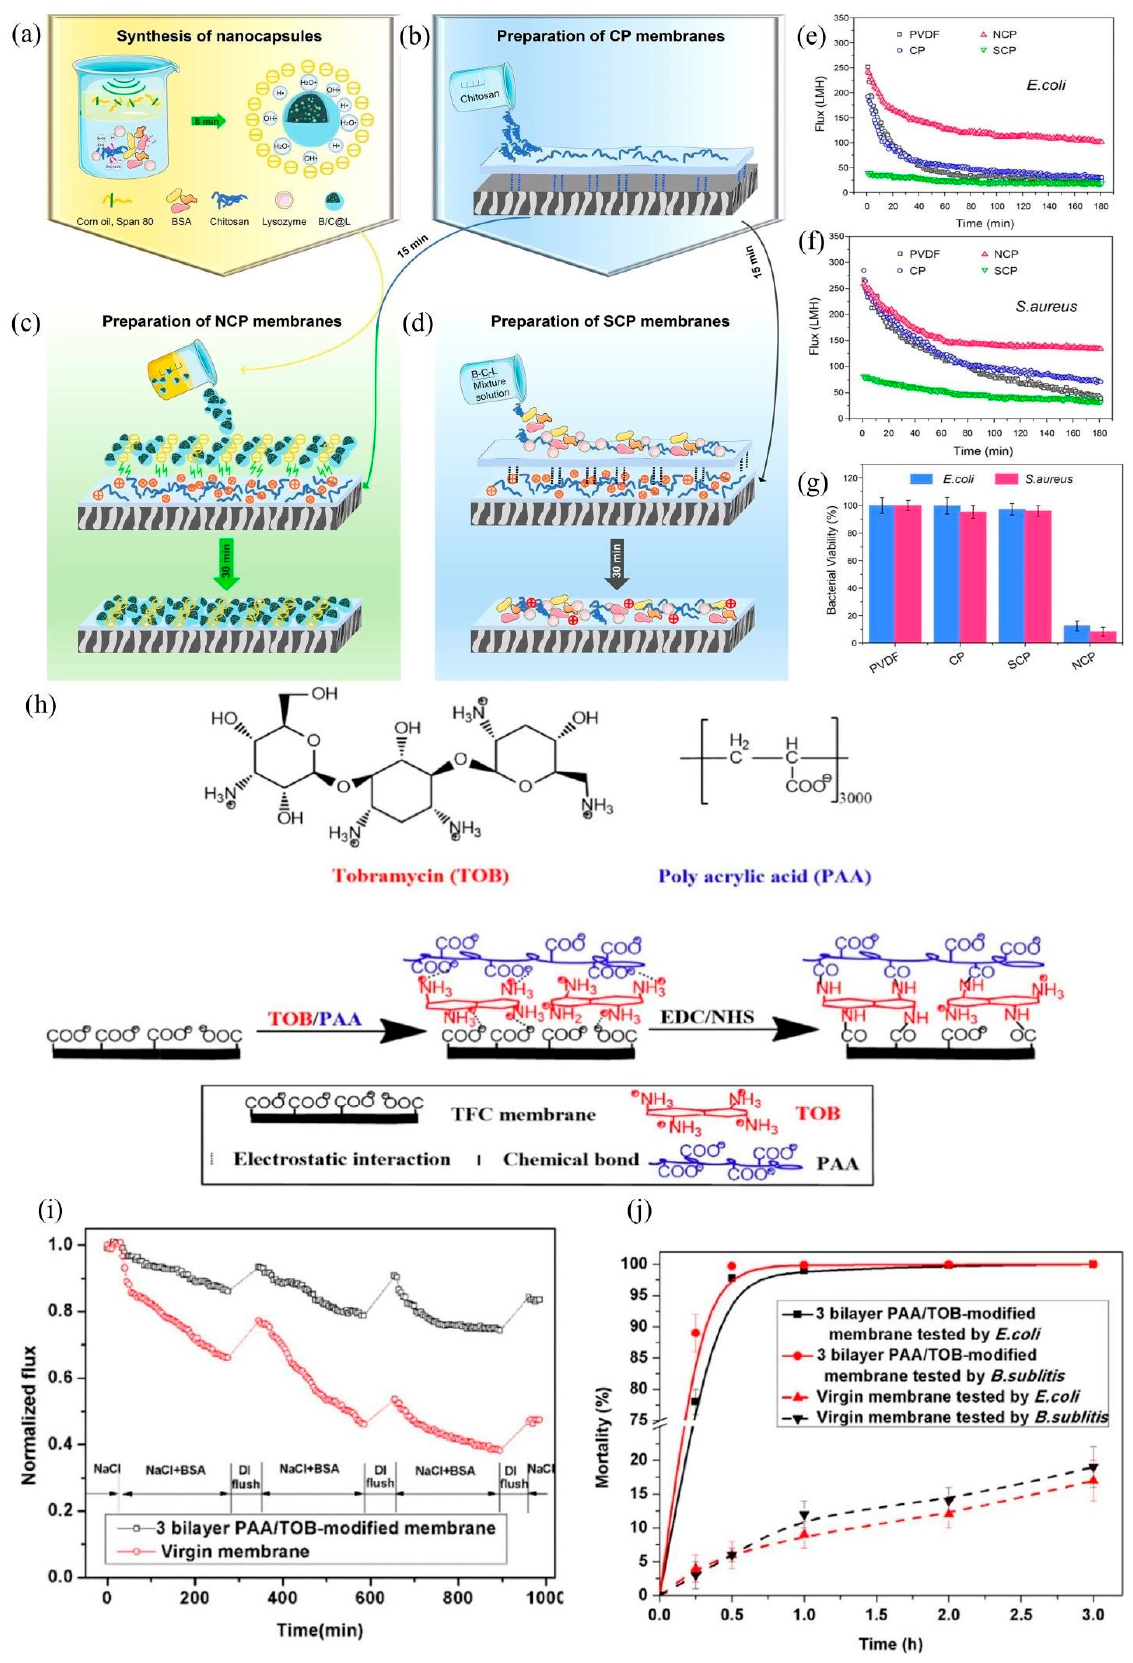
Figure 8. Schematic for the preparation of ( a ) B/C@L nanocapsules, ( b ) CP membrane, ( c ) NCP